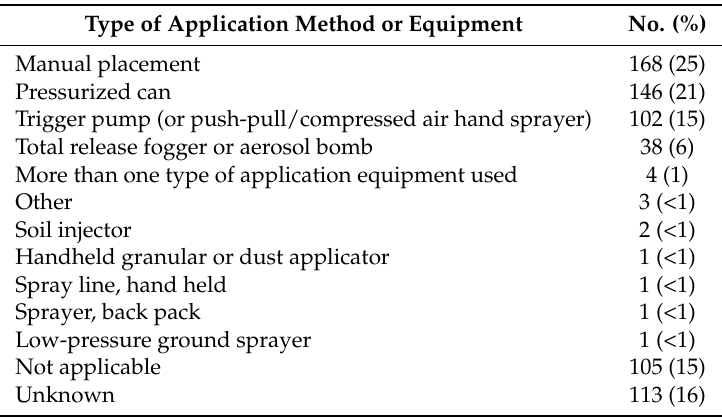
Table 6. Distribution of events in childhood by equipment or application method.